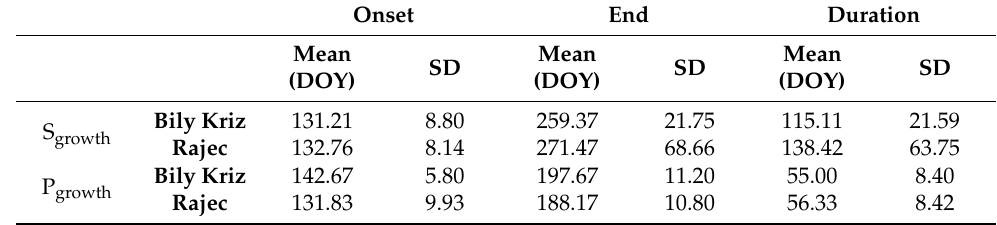
Table 3. Mean values and standard deviation (SD) of onset, end and duration of secondary growth (S growth ) and primary growth (P growth ) at the ESP Rajec and Bily Kriz in 2016–2019.